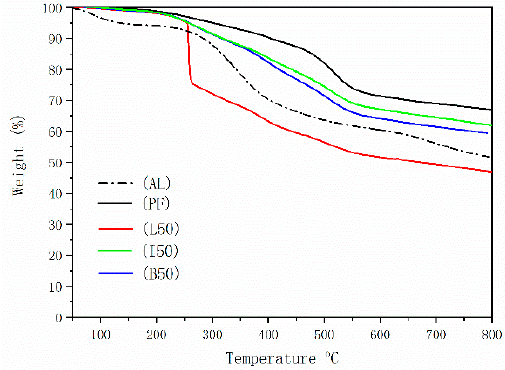
Figure 8. TGA analysis of Alkali lignin, PF, ALPF(L50), DLPF (I50, B50) resins with 50% lignin substitution.